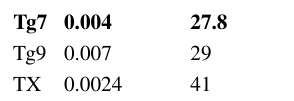
characterization